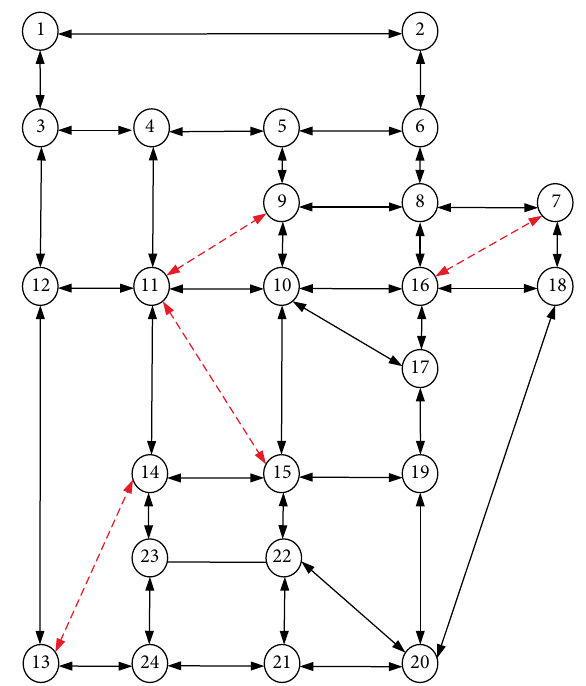
Figure 3: Sioux Falls test